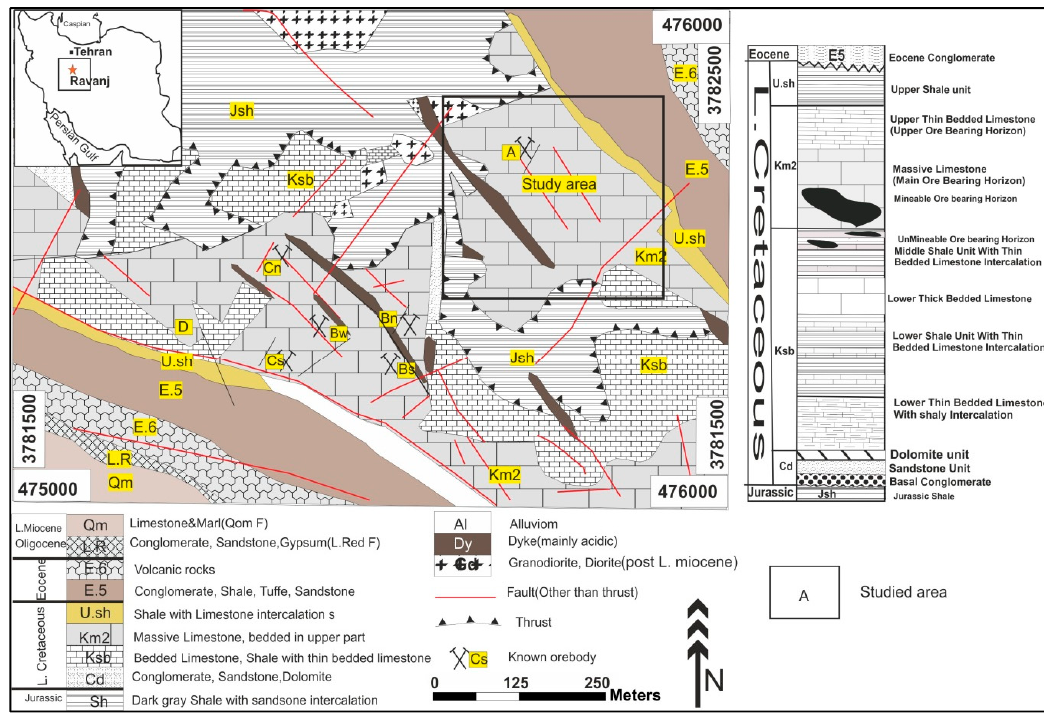
Figure 1. Geological map of the Ravanj anticline and location of the study area (after [13]). The lithostratigraphic columnar section shows relative position of known mineralization in the Ravanj lower Cretaceous sequence.